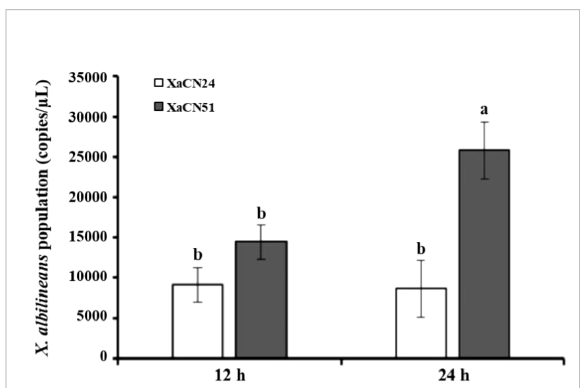
FIGURE 3 Population densities of two strains of Xanthomonas albilineans (XaCN24 and XaCN51) expressed as the number of genome copies determined by qPCR. Each vertical bar represents the mean ± standard deviation of three leaf subsamples collected 12 and 24 hours after inoculation and three technical replicates per subsample. Each leaf subsample is issued from a pooled sample of fragments collected from 35 inoculated leaves. Means with the same letter are not signi fi cantly different at P = 0.05 according to Duncan ’ s